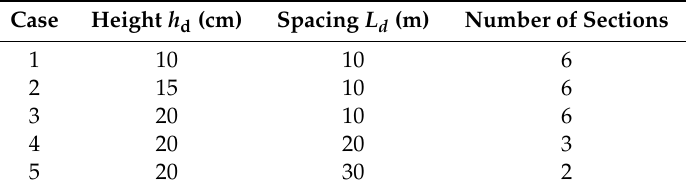
Table 3. Details of the check dam system design cases used for the estimation of the effects of check dam heights and spacing on the infiltration rate of grassed channel.